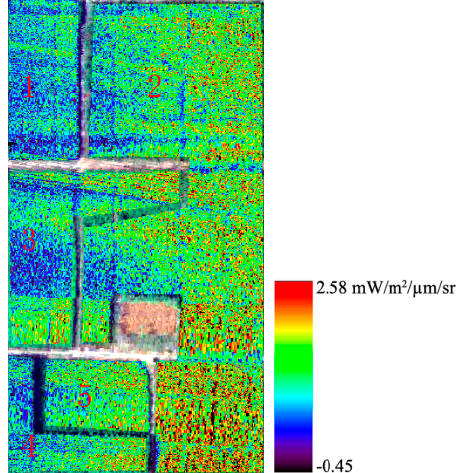
Sensors 2016 , 16 , 480